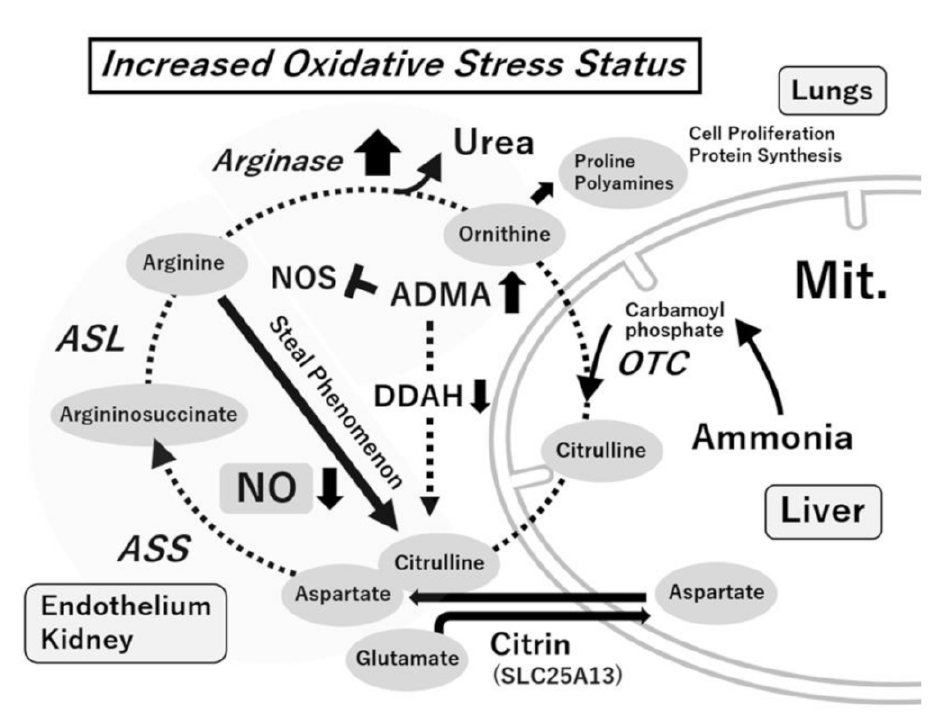
Figure 2. Metabolic network centered on arginine. In the physiological state, arginine is regenerated from citrulline by citrulline–arginine recycling in the blood vessel and the kidney, and the vascular endothelium cells can maintain NO synthesis via this pathway. In inflammatory pathology (increased oxidative stress status), arginase is induced in many cells, such as the blood vessels and macrophages, and NO synthesis derived from the vascular endothelium decreases through the “arginine steal phenomenon”. Increased catabolism of arginine via arginase may not only compromise the ability to synthesize NO constitutively but also increase the production of ornithine, a precursor for the synthesis of proline and polyamines, which are required for cell proliferation and collagen synthesis in the lungs. Abbreviations: ADMA, asymmetric dimethylarginine; ASL, argininosuccinate lyase; ASS, argininosuccinate synthetase; DDAH, dimethylaminohydrolase; NO, nitric oxide; NOS, nitric oxide synthase; OTC, ornithine transcarbamylase; PRMT, protein arginine